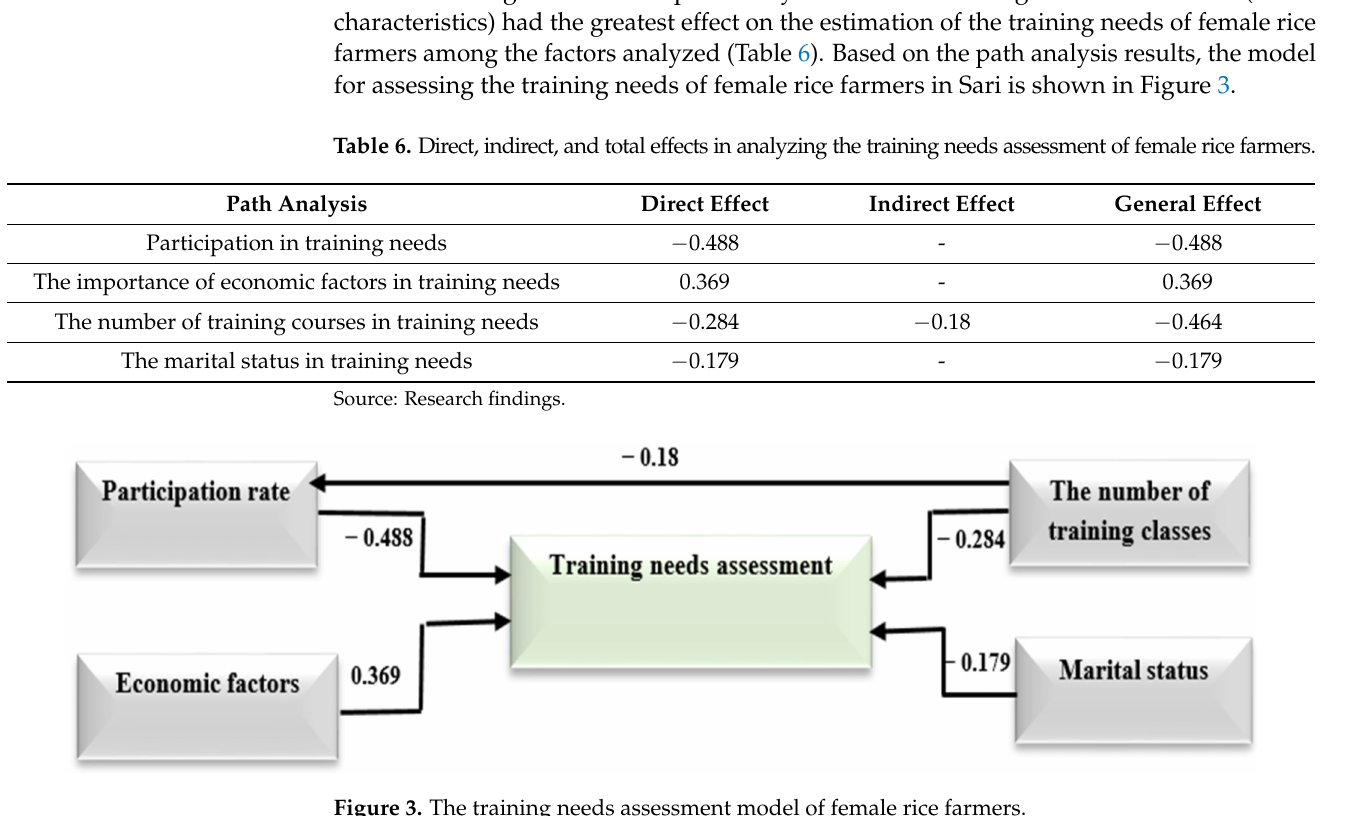
Figure 3. The training needs assessment model of female rice